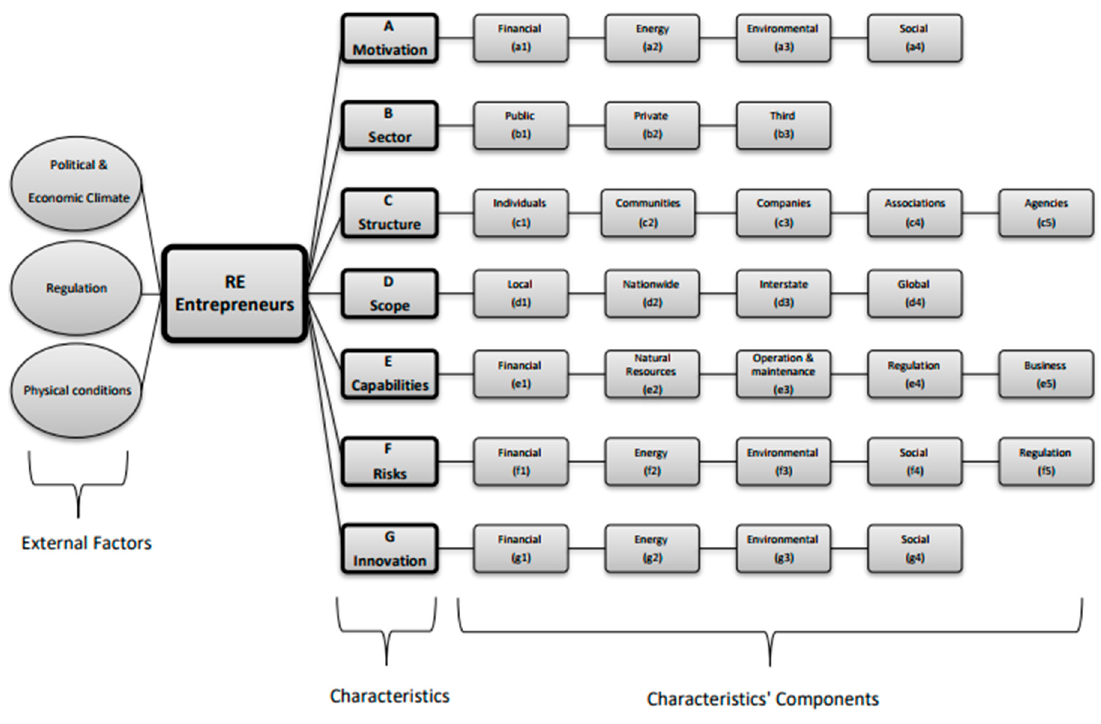
Figure 1. Profile structure of RE entrepreneurs.